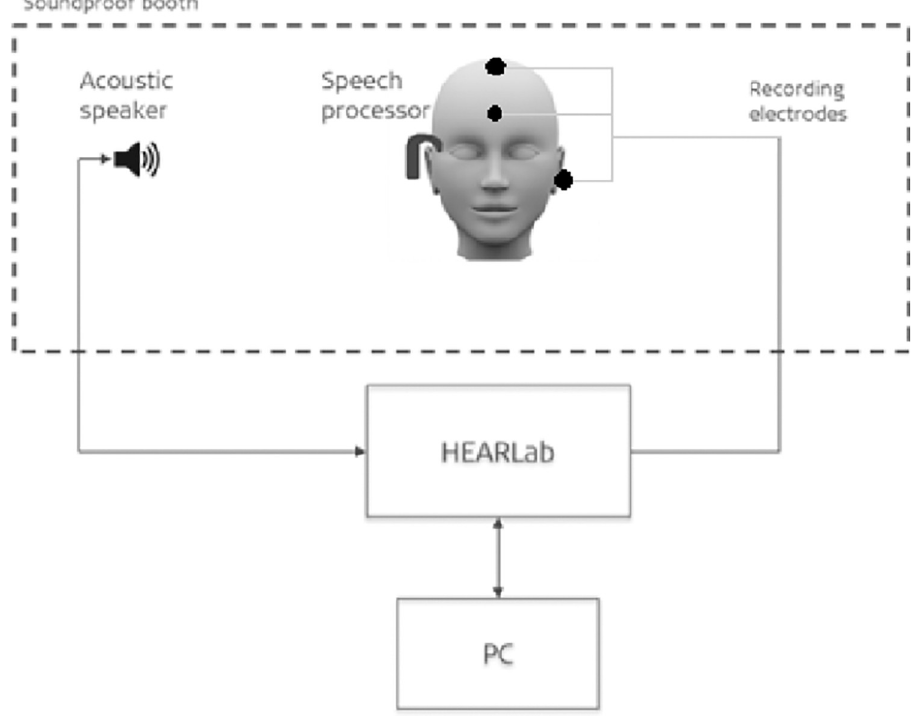
Fig 1. Electrode montage for CAEP recording. Active electrode at the vertex (Cz), reference on the mastoid contralateral to the CI and the ground placed at the forehead. Electroencephalogram (EEG) electrodes were used for the